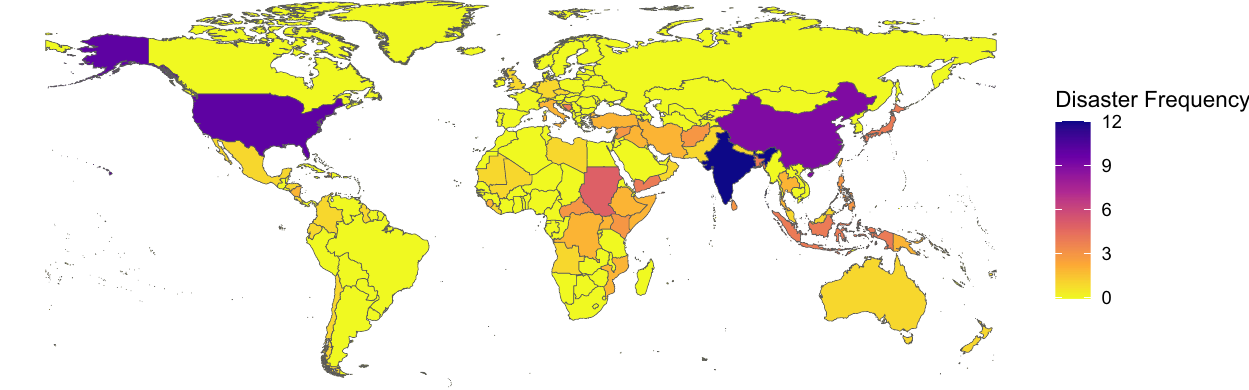
Figure 2. Frequency of reported post-disaster disease outbreaks by country for each 137 separate disaster events found in the literature search 32